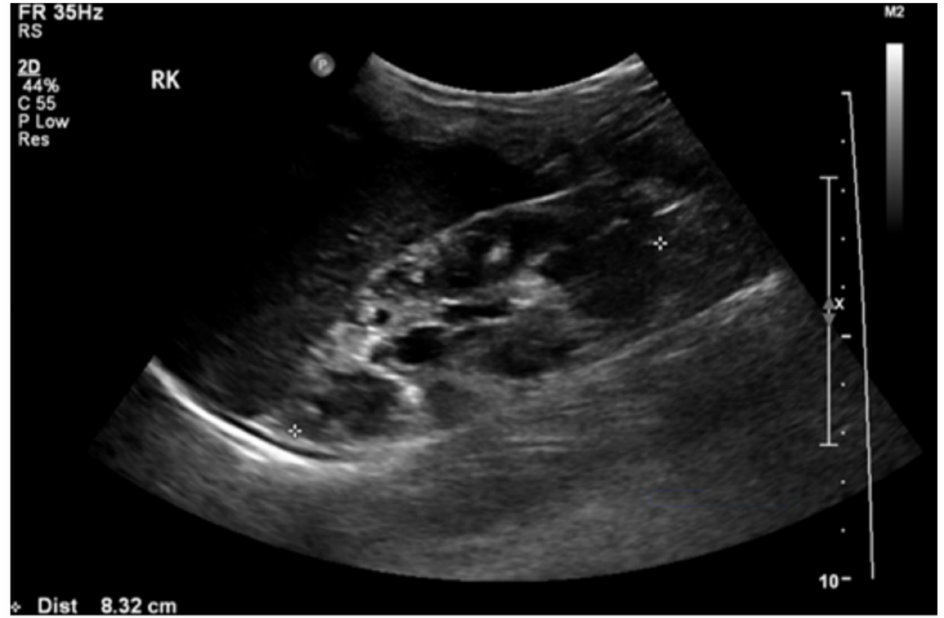
Figure 2. Renal ultrasound showed loss of corticomedullary differentiation of the right kidney with multiple cysts of variable sizes.